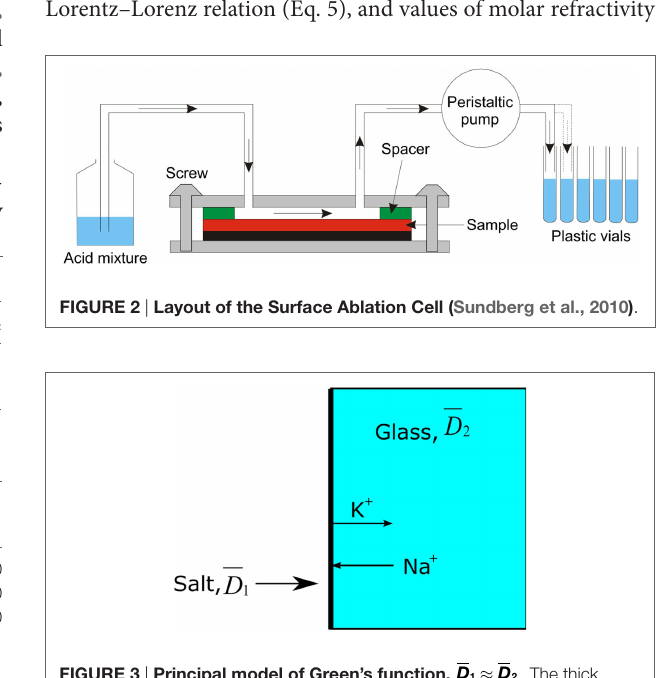
FiGUre 3 | principal model of Green’s function, D D 1 2 » . The thick black line represents the salt layer with 100% concentration of, e.g., K + .